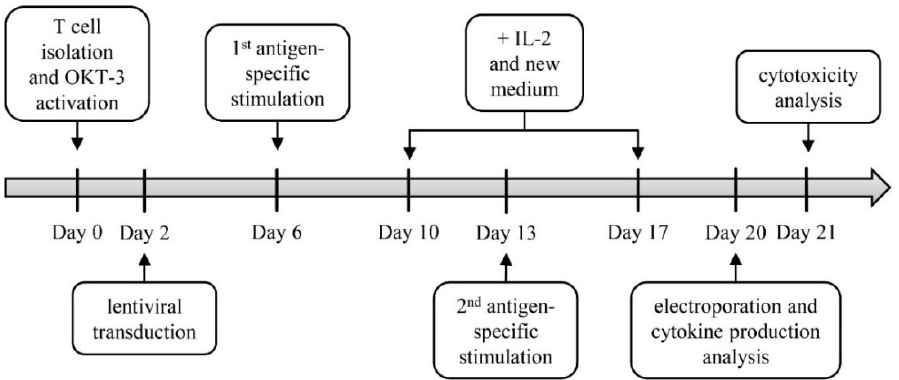
Figure 1. Experimental procedure for the generation of T cells expressing two additional receptors (TETARs). CD8 + T cells were first isolated from peripheral blood mononuclear cells (PBMCs) and subsequently activated with OKT-3, CD28 antibody, and IL-2 (T cell isolation and activation). After two days, T cells were lentivirally transduced with the gp100 TCR virus (lentiviral transduction). On day 6 and 13, antigen-specific stimulation of transduced T cells with gp100 peptide-loaded A375M melanoma cells was performed (antigen-specific stimulation). New medium and IL-2 was added to the cells on day 10 and 17 ( + IL-2 and new medium). Transduced T cells were then electroporated with mRNA encoding the CSPG4-specific chimeric antigen receptor (CAR), and functionality assays, i.e., analysis of cytokine secretion and cytotoxicity, were conducted at day of or one day after electroporation. In addition, a receptor expression analysis was performed in a time-course experiment.